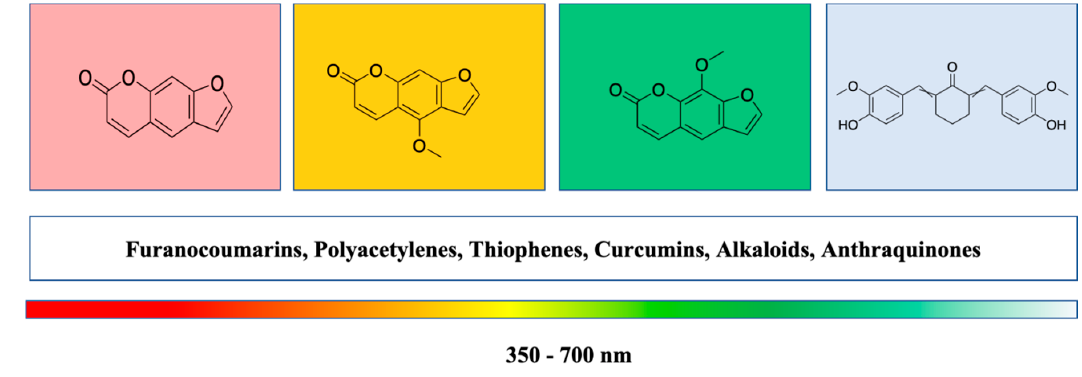
Figure 2. Phototherapeutic window of natural compounds.